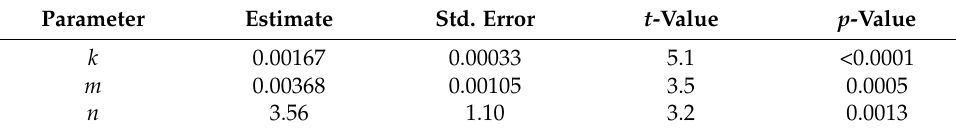
Table 8. Parameter estimates for stand density model (Equation